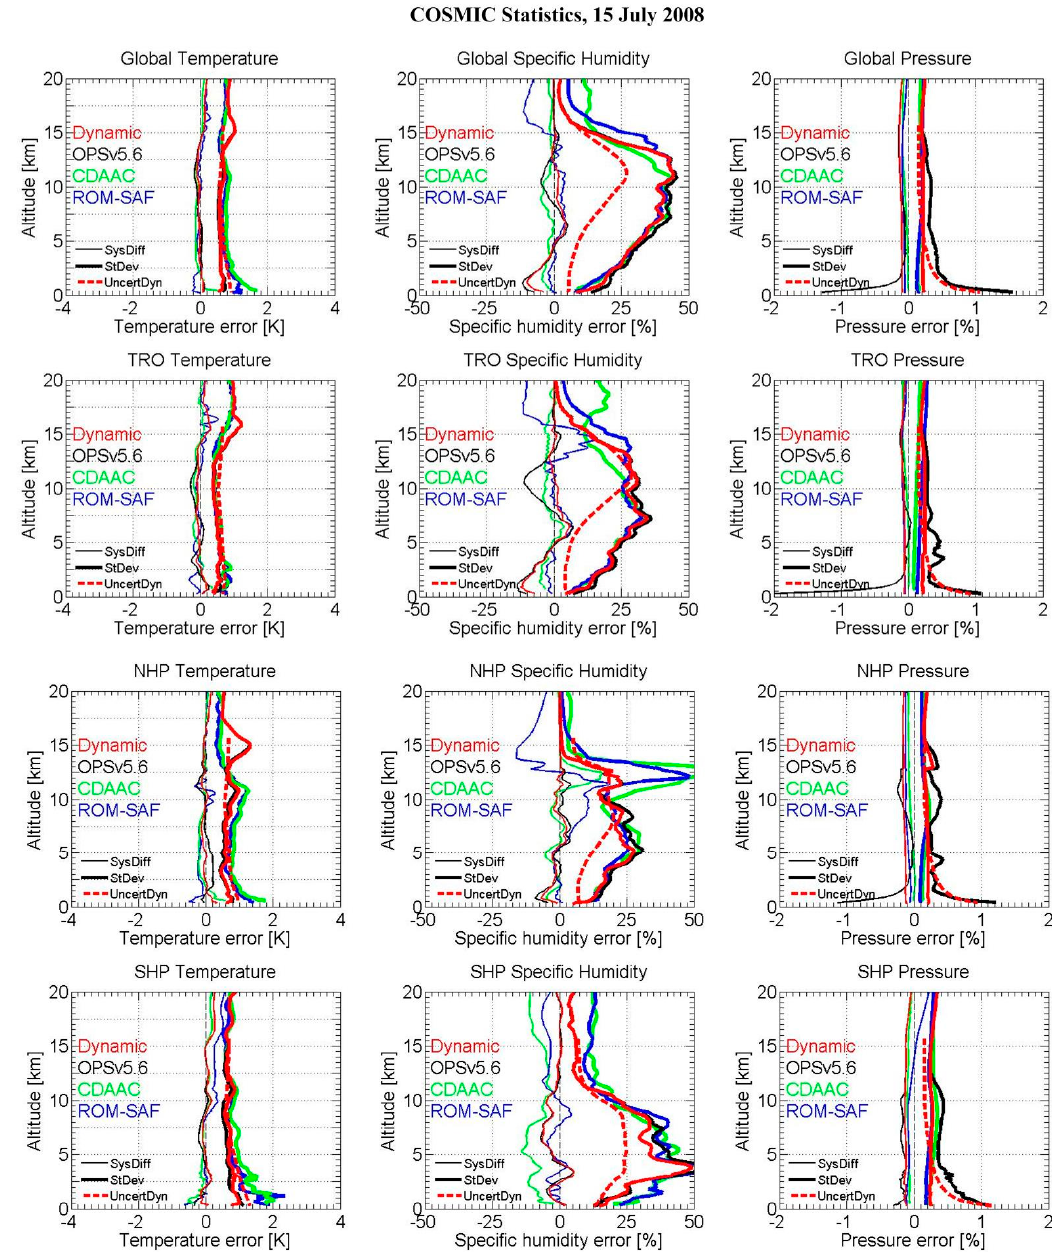
Figure 9. Systematic differences (SysDiff) and standard deviations (StDev) of retrieved temperature (left column), specific humidity (middle column), and pressure (right column), relative to ECMWF co-located analysis profiles as reference, of the ensemble of COSMIC events on 15 July 2008. Statistics for the dynamic (red), OPSv5.6 (black), CDAAC (green), and ROM-SAF (blue) approach are shown for four representative regions (top to bottom: Global, TRO, NHP, SHP). The propagated uncertainties of retrieved profiles from the dynamic approach (UncertDyn; red-dashed) are shown as well.